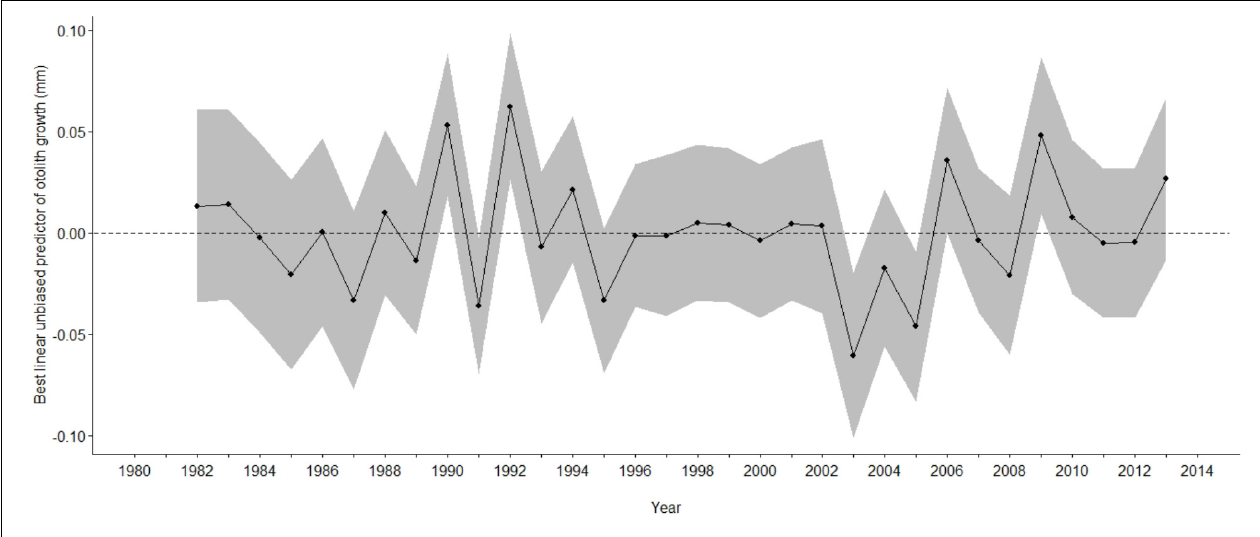
FIGURE 4 | Best linear unbiased predictor of growth, (dots and solid lines) against year of M. paradoxus caught off Namibia estimated from the most parsimonious mixed effects model on otolith increments ( Table 3 ). Grayed areas indicate 95% confidence limits and the dashed line indicates mean growth.